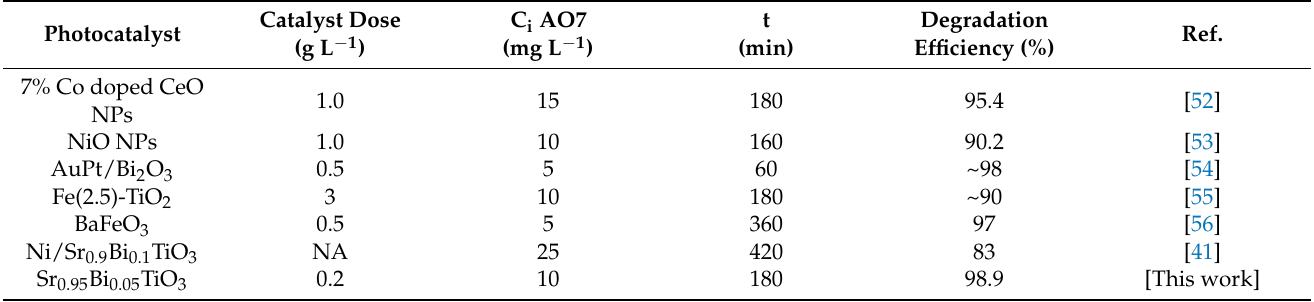
Table 3. Comparing the photocatalytic activity of different photocatalysts on the degradation of aqueous solutions of AO7 under visible light radiation.